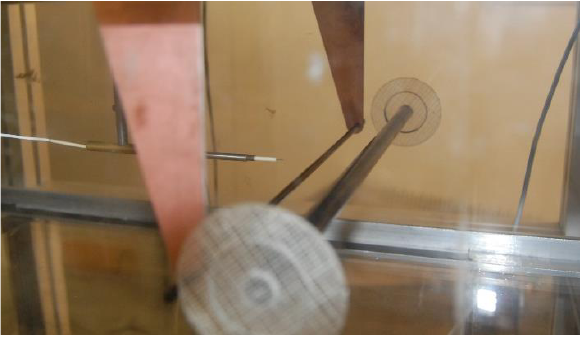
Figure 1. The hot wire probe and